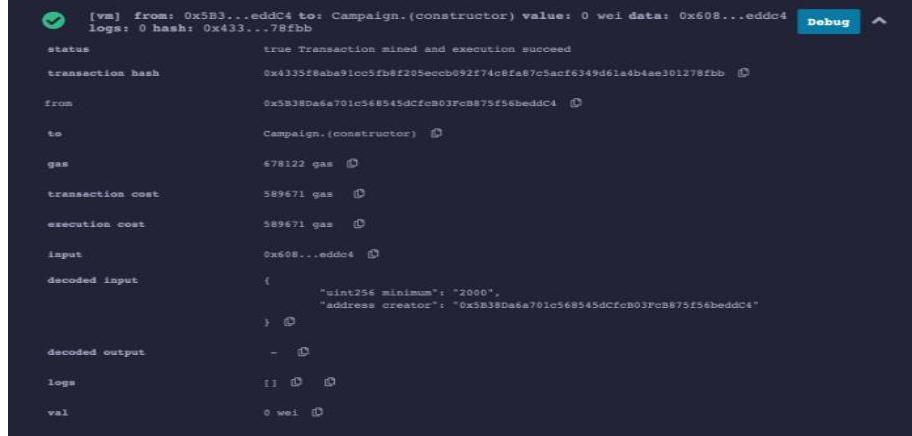
Figure 4. Transaction cost.